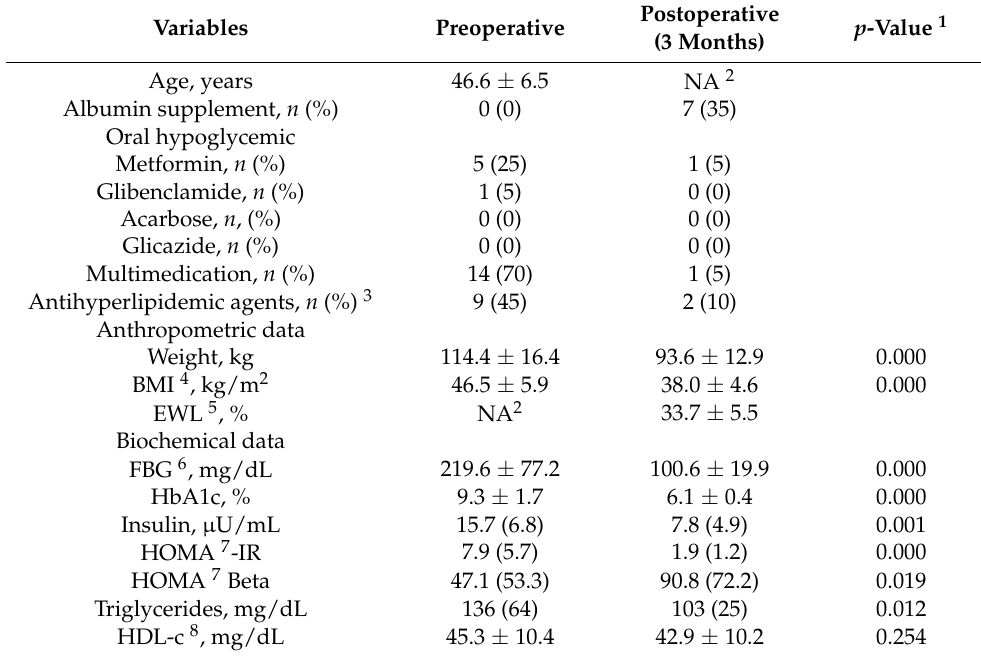
Table 1. Characterization of the participants according to clinical and biochemical variables before and three months after